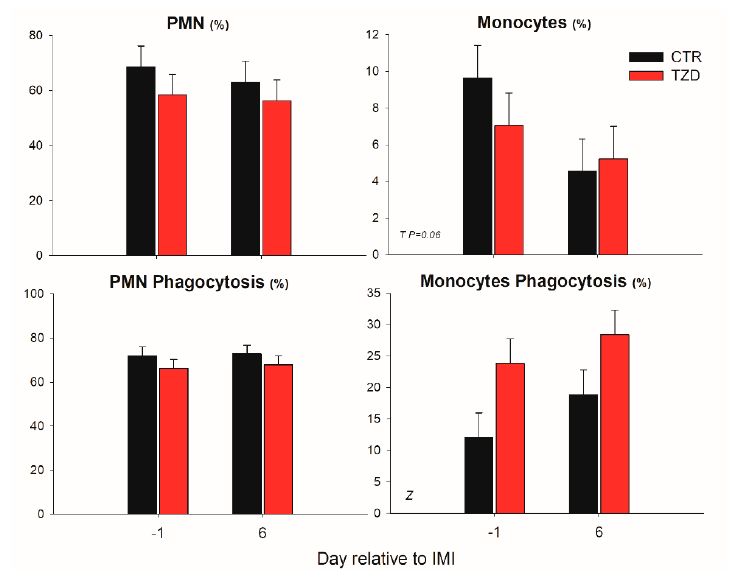
Figure 6. Effect on leukocytes differential and phagocytosis of 2,4-thiazolidinedione (TZD) daily injection and intramammary infusion (IMI) with Strep. uberis (IMI) in Saanen dairy goats. Reported are the percentages of granulocytes (PMN) and monocytes and their percent phagocytosis. Letters in the graph denote significant ( p < 0.05) effects of time (T) and 2,4-thiazolidinedione treatment (Z).